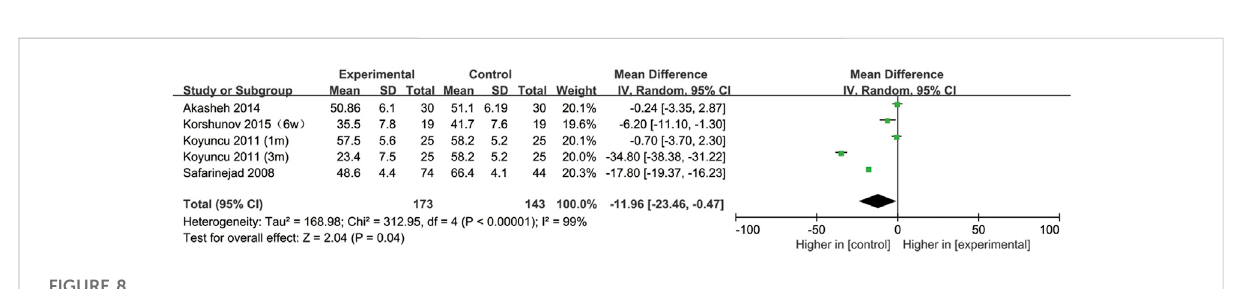
Forest plot for the association between SSRIs used and sperm